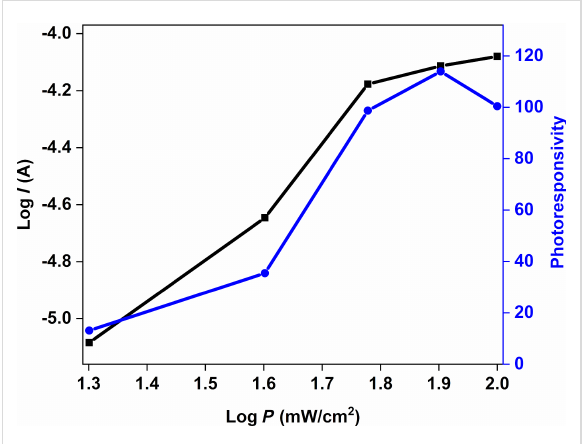
Figure 8: Graphs of log I and photoresponsivity as functions of log P of the Au/CuNiCoS 4 /p-Si photodiode for various illumination power densi- ties.